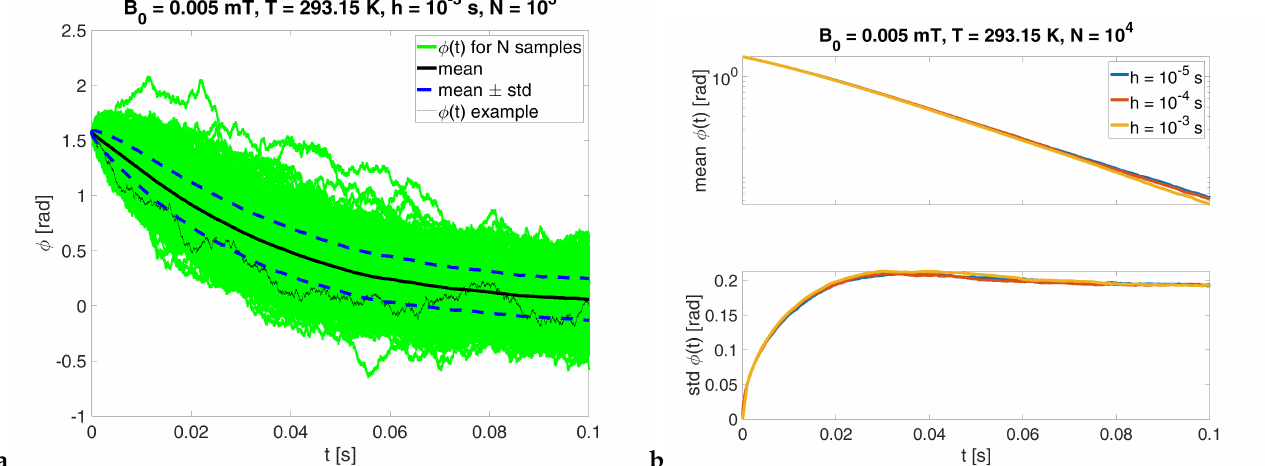
Figure 3. ( a ) Time evolution of ϕ ( t ) for N = 10 3 samples of the SDE model, i.e., inertial, magnetic, quasi-steady viscous, and stochastic Brownian torques in the weak B 0 field limit (timestep h = 10 − 5 s). ( b ) Comparison of time evolution of mean and std values of ϕ ( t ) averaged over N = 10 4 samples of the SDE model for different finite timesteps h